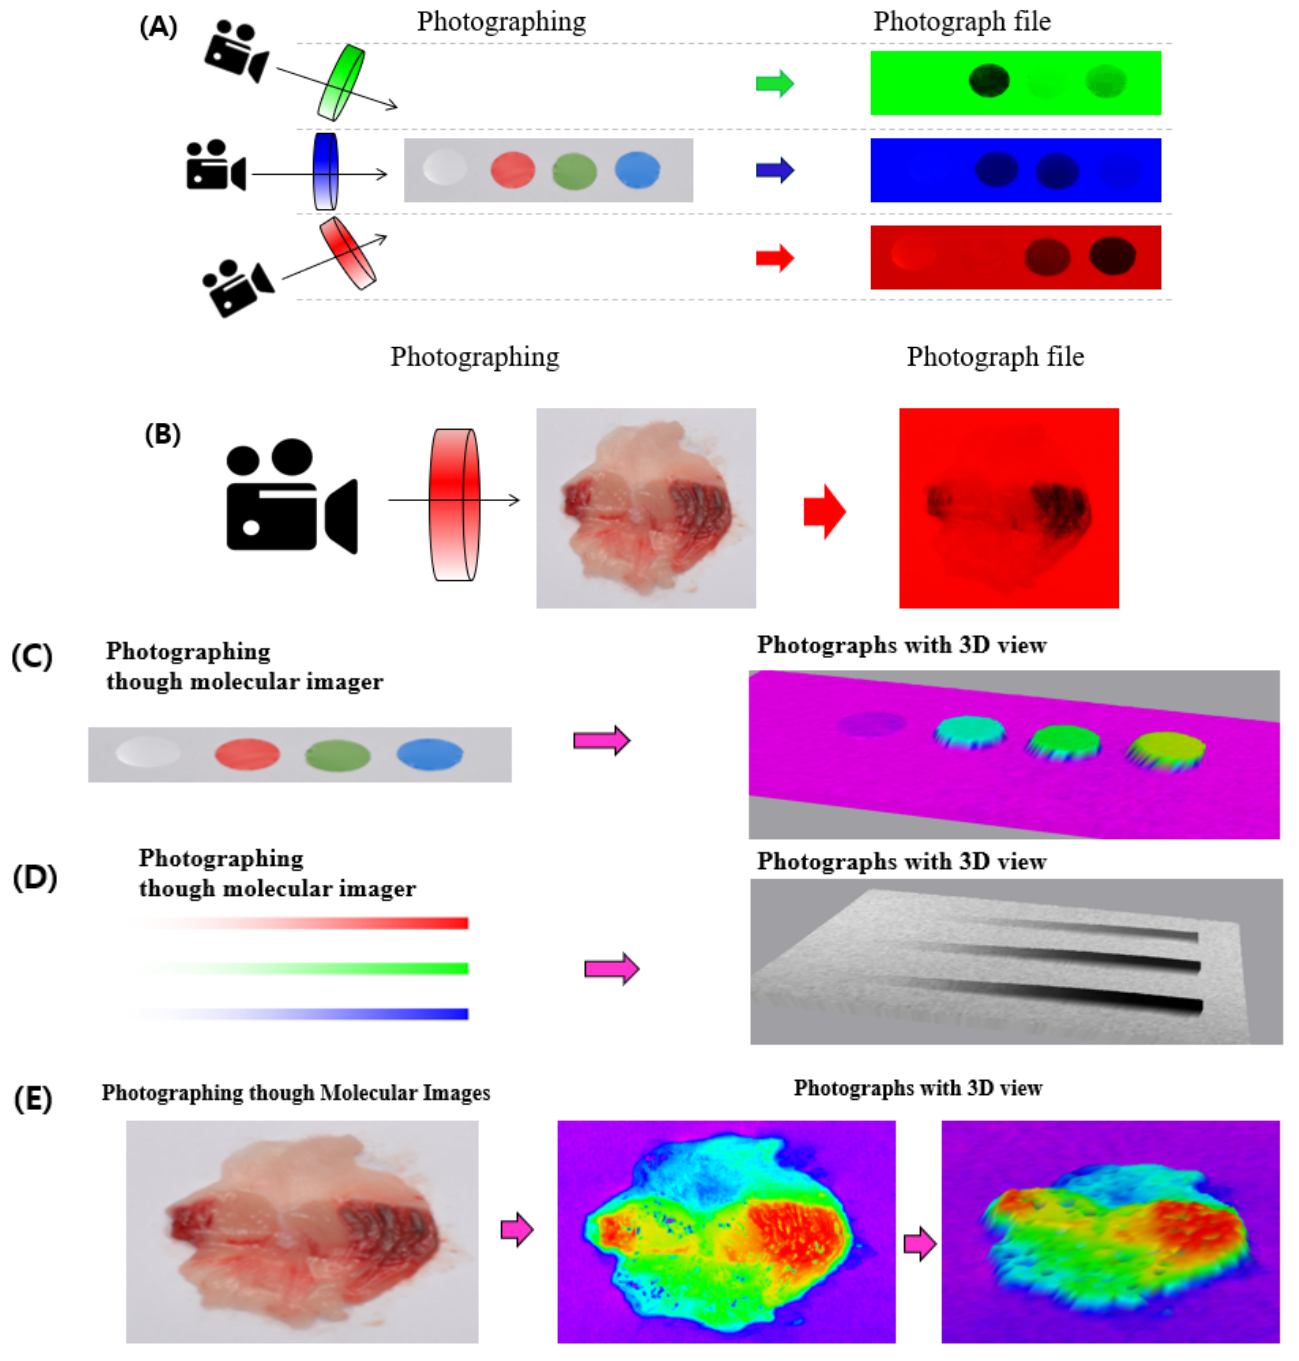
Figure 1. Application of shielding and 3D picture on gastric ulcer image analysis. ( A ) The digital camera was shielded with a cellophane film (green, blue, and red), and the color marker picture was taken. Each color was hidden with the same color shielding after photographing. ( B ) The ethanol-induced gastric organ in a mouse model was photographed with red cellophane film and showed a customized photograph file, which was only determined with a red color. ( C ) The color marker was photographed by a molecular imager. Red, green, and blue without white indicate the height of color density. ( D ) As the color density increases, the height becomes higher in the 3D picture. ( E ) The ethanol-induced erythema damage in a mouse is displayed as a 3D image of the gastric organ.